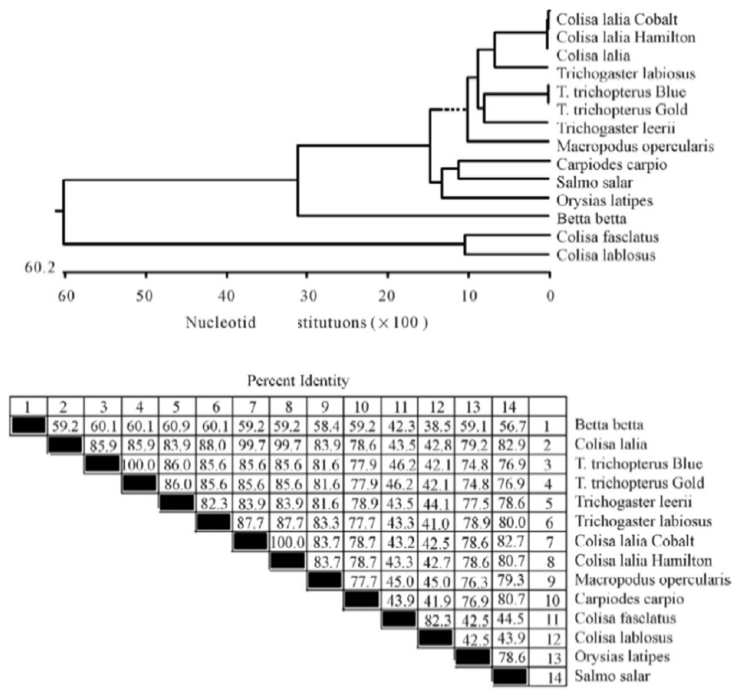
Figure 8. Phylogenetic tree of the cytochrome b fragment based on nucleotide sequences of various fish species. The length of each pair of branches represents the distance between sequence pairs, while the units at the bottom of the tree indicate the number of substitution events. The phylogenetic tree was constructed by Clustal W and analysis alignment in the MegAlign program (DNASTAR). Percent DNA sequence identities are also shown [2]. Biology 2021 , 10 , x FOR PEER REVIEW